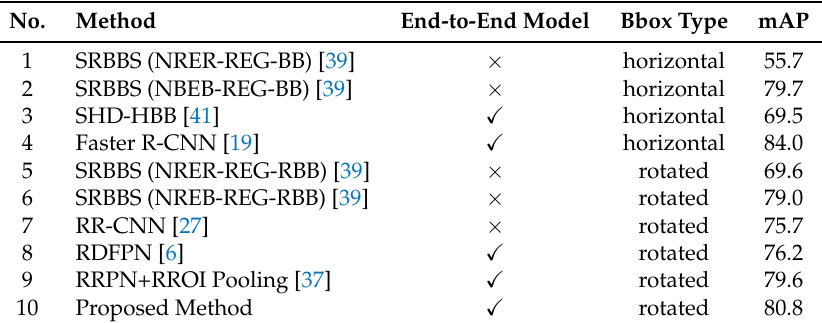
Table 4. Detection results of state-of-the-art methods on HRSC2016 dataset.